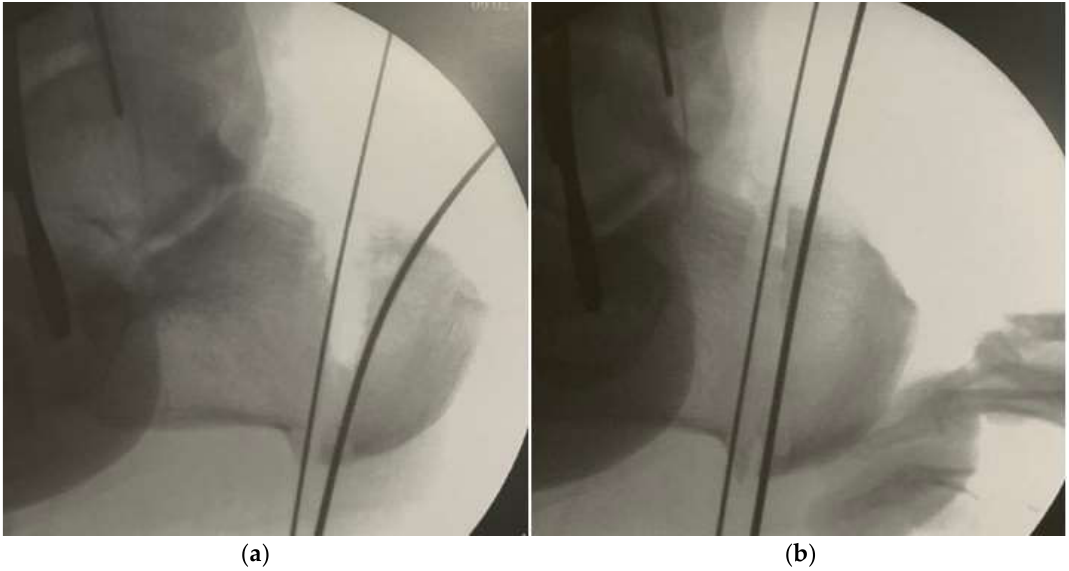
Figure 2. (a) Dorsal base closing wedge resected according to preoperative planning. ( b ) Dorsal base wedge closure. Another portal is made under a fluoroscopic view, a lateral closing wedge performed at the center of the cuboid (Figure 3), and a punctual incision made lateral to the expected site of the superficial peroneal nerve. Next, the burr is inserted perpendicularly to the bone to avoid dissection or the passage of the burr through the soft tissue in this area, given that numerous unpredictable branches of the superficial peroneal nerve are present. Once the burr is inserted into the bone, the windshield wiper movement is repeated. Forced forefoot abduction completes the osteotomy, which does not usually include fixation.